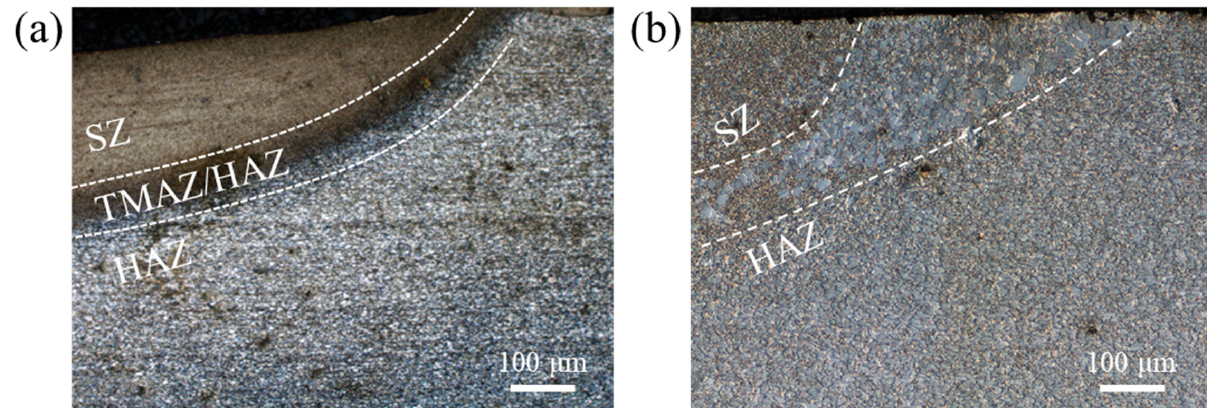
Figure 6. ( a ) The microstructure showing the interfaces between SZ, TMAZ, and HAZ for the FSW400-400 and ( b ) grain growth in the microstructure for FSW400-400 sample subjected to the post-weld heat treatment at 650 °C.